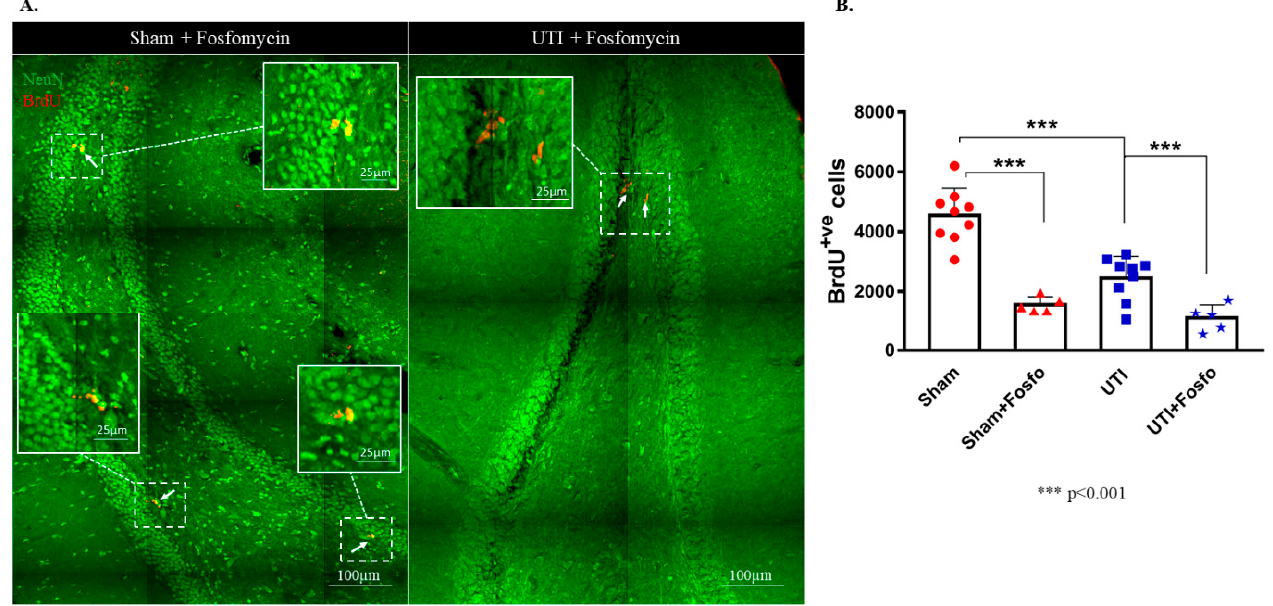
Figure 7. Treatment with Fosfomycin (fosfo) decreases the basal level of BrdU-positive cells and does not revert the decrease in NSCs on day 4 post infection. ( A ) Representative confocal images of the DG of Fosfomycin-treated sham ( n = 5) and UTI rats ( n = 5) showing NeuN (green) and BrdU-positive cells (red; arrows). Images were taken as Z stacks and tile scan using a 40 × -oil objective. ( B ) Stereological quantification of BrdU-labeled cells in the DG of Fosfomycin-treated sham and UTI rats sacrificed on day 4 post infection. Determination of statistical significance of differences was generated using one-way Anova followed by Tukey’s multiple comparison test.